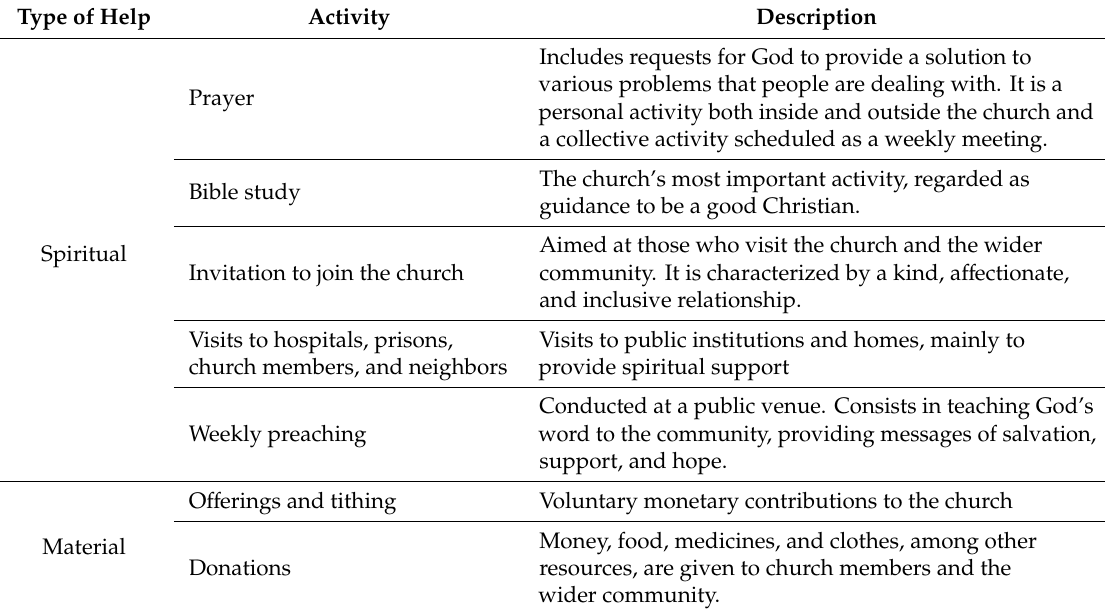
Table 3. Prosocial activities at the Pentecostal Methodist